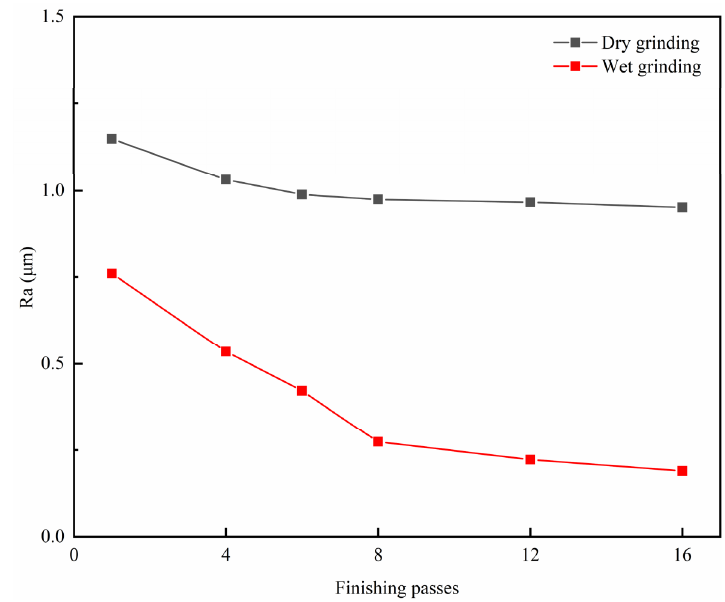
Figure 8. Variation in surface roughness with the finishing passes for both dry and wet grinding.